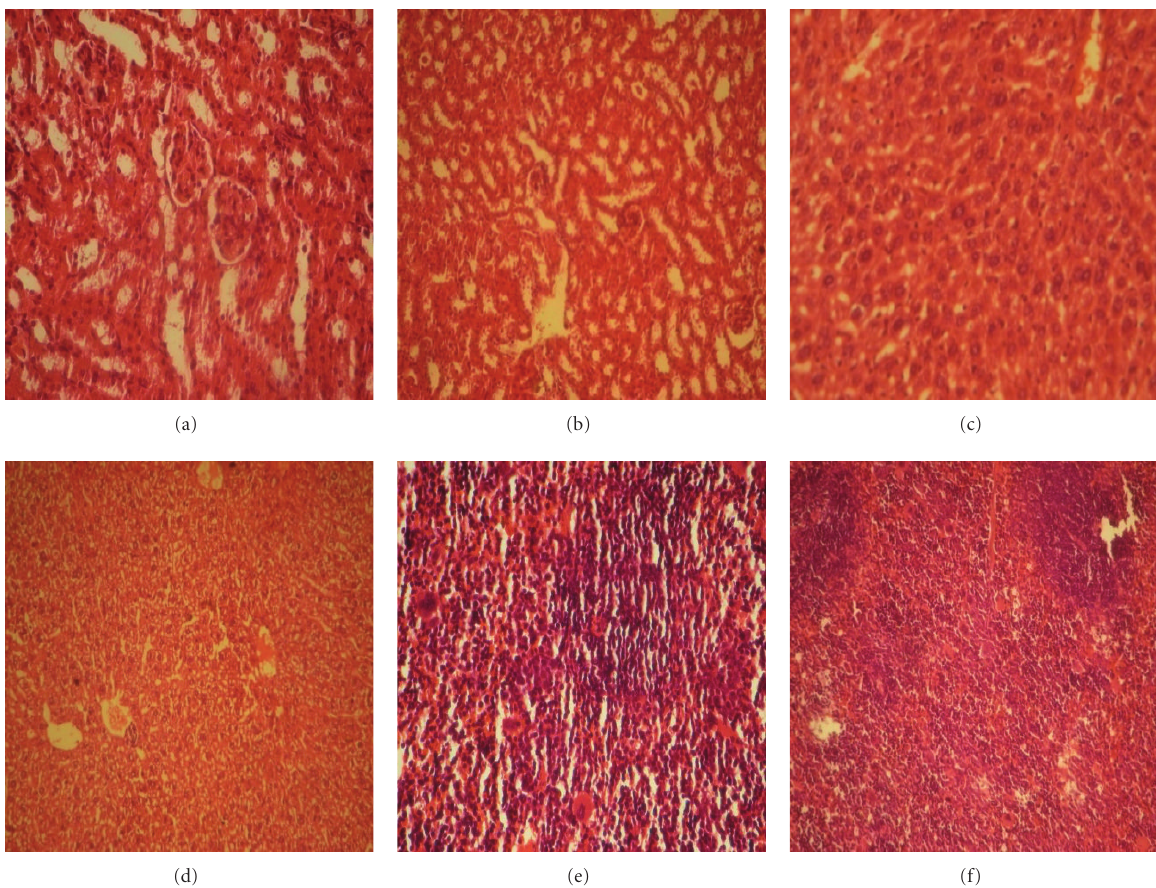
Figure 6: Light micrographs of H- & E-stained sections of formalin-fixed sections of control and 200 mg/kg PST001-treated mice. (a) Control kidney, (b) 200mg/kg PST001-treated Kidney, (c) Control Liver, (d) 200mg/kg PST001 treated liver, (e) Control Spleen, and (f) 200mg/kg PST001 treated spleen.